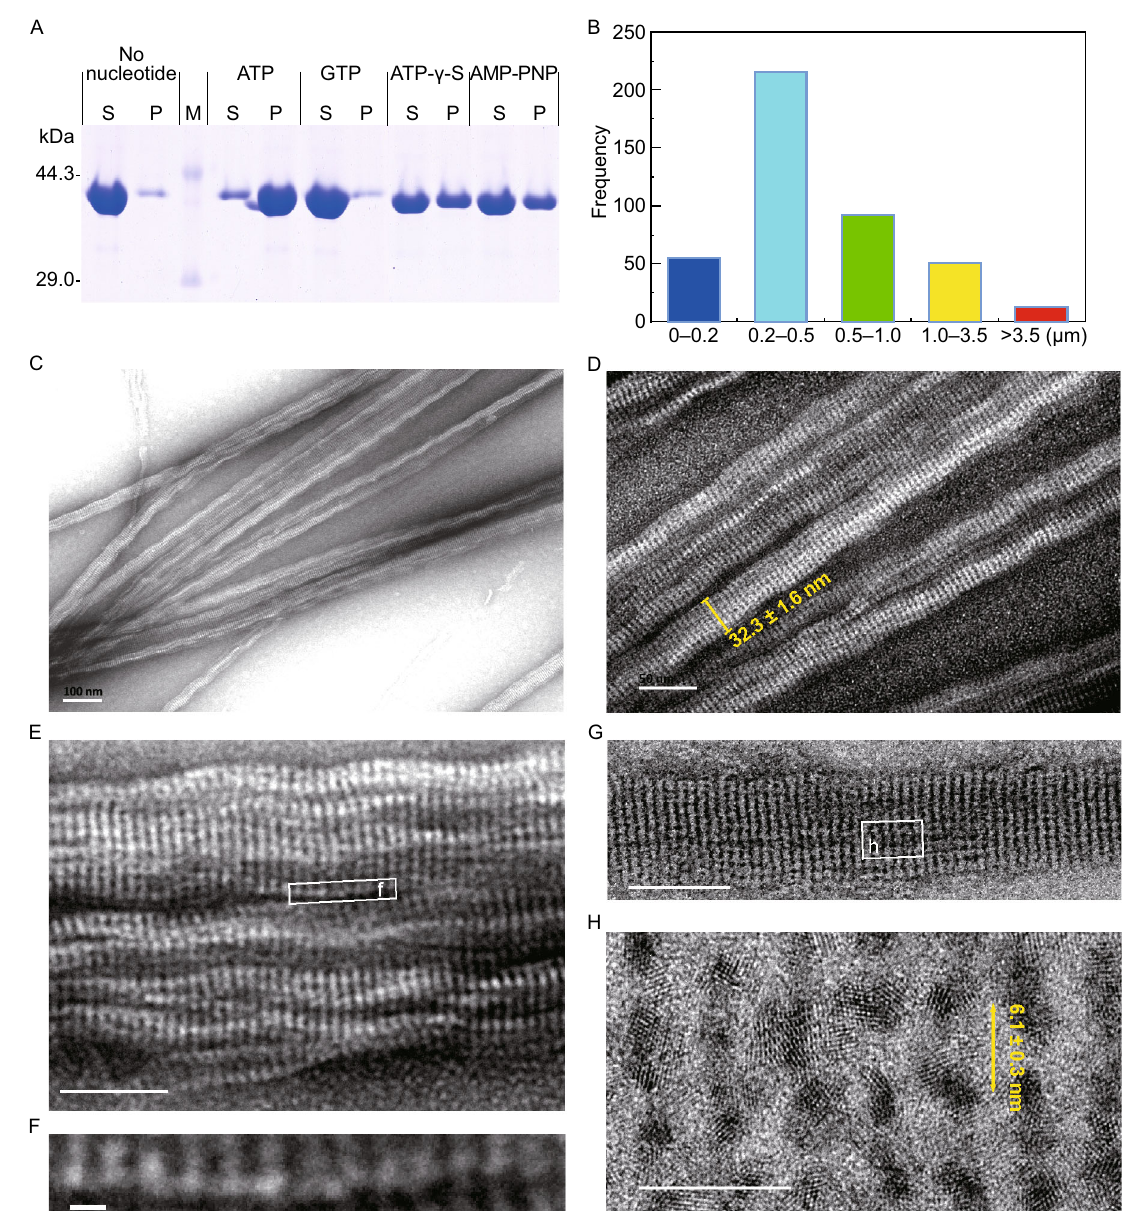
Figure 4. MamK fi laments formed in the presence of ATP. (A) MamK polymerization in the presence of various nucleotide states was assessed by a pelleting assay. The supernatant (S) and pellet (P) fractions were analyzed by SDS-PAGE. In the presence of ATP, ATP- γ -S or AMP-PNP, the proportion of the pellet in the total protein was clearly increased compared to the negative control without any nucleotide. (B) The distribution of the fi lamentous lengths formed in the presence of ATP, Mg 2+ and NaCl. The majority of MamK fi laments ranged from 0.2 to 0.5 μ m in length, and the well-developed fi laments were more than 3.5 μ m in length. (C – H) Negatively stained MamK polymers visualized by TEM. In vitro , MamK polymerized into well-ordered fi laments comprised of multiple fi laments in an ATP-dependent manner. Panel C scale bars, 100 nm; panel D scale bar, 50 nm; panel E scale bar, 50 nm; panel F scale bar, 5 nm; panel G scale bar, 50 nm; and panel H scale bar,